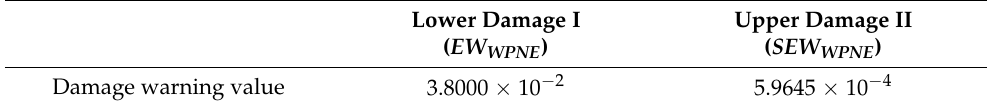
Table 2. Damage warning values for the CCRFB.